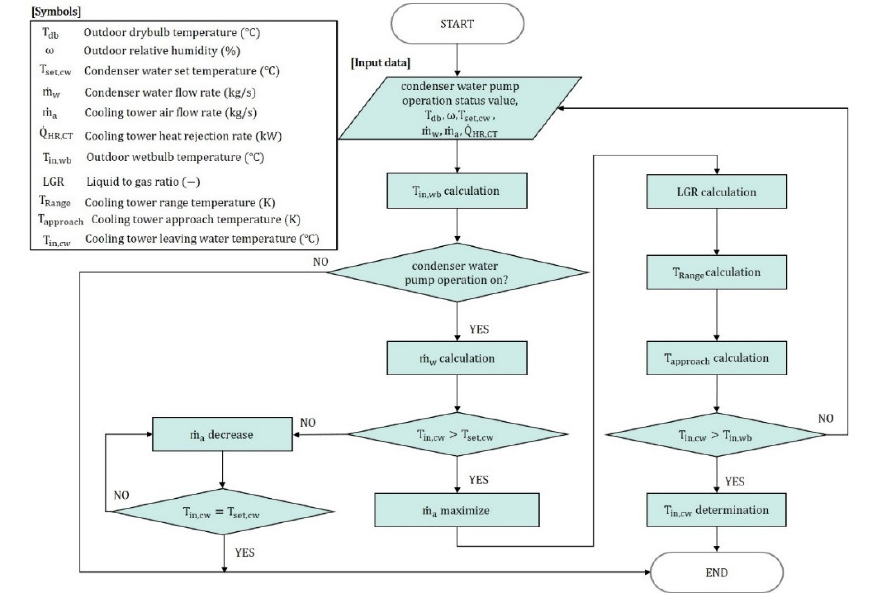
Figure 7. Cooling tower control algorithm for low approach temperature.